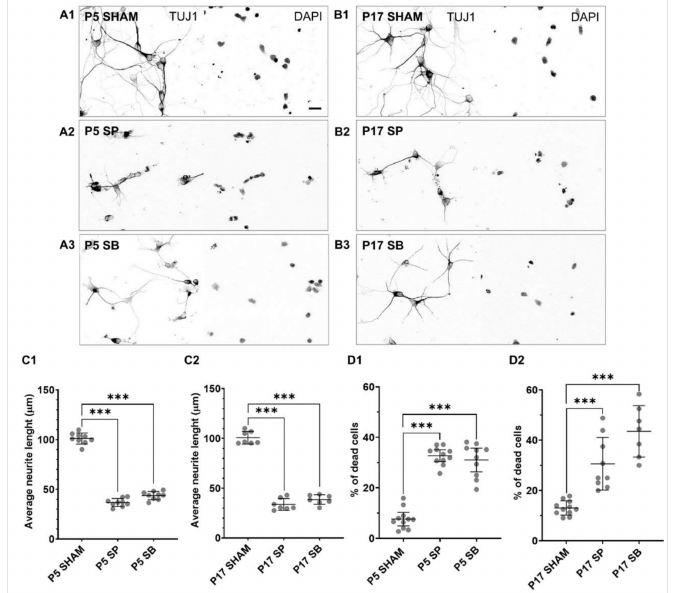
Figure 3. Reticence of neuronal differentiation by ATF3 inhibition. Primary neuronal cultures derived from the P5 ( A1 – A3 ) and P17 ( B1 – B3 ) cortex of M. domestica were treated at DIV1 with the MAPK inhibitors, JNK/c-Jun inhibitor SP600125 (SP), or the p38 inhibitor SB203580 (SB) for 24 h. The cells were fixed and stained at DIV7. Neurons were stained for TUJ1 (left panel), and their nuclei were counterstained with DAPI (right panel). For better visualization of neurites, images are shown in the grayscale. Scale bar is 20 µ m. ( C1 ) The scatter plot shows the average neurite length for P5 cortical neurons for the experimental conditions shown from ( A1 – A3 ). Data are shown as a scatter plot with mean ± SD. The total number of neurites analyzed P5 SHAM 369; SP 272; SB 346. One-way ANOVA followed by Holm-Š í d á k multiple comparisons test. P5 SHAM vs. P5 SP p < 0.001 ***; P5 SHAM vs. P5 SB p < 0.001 ***. ( C2 ) The scatter plot shows the average neurite length for P17 cortical neurons for the experimental conditions shown from B1-B3. Data are shown as a scatter plot with mean ± SD. The total number of neurites analyzed P17 SHAM 385; SP 181; SB 394. One-way ANOVA followed by Holm-Š í d á k multiple comparisons test. P17 SHAM vs. P17 SP p < 0.001 ***; P17 SHAM vs. P17 SB p < 0.001 ***. ( D1 ) The scatter plot shows the percentage of dead cells with mean ± SD for the experimental conditions shown from ( A1 – A3 ): The total number of cells analyzed, respectively: 897, 468, 497. One-way ANOVA followed by Holm-Š í d á k multiple comparisons test. P5 SHAM vs. P5 SP p < 0.001 ***; P5 SHAM vs. P5 SB p < 0.001 ***. ( D2 ) The scatter plot shows the percentage of dead cells with mean ± SD for the experimental conditions shown from ( B1 – B3 ): The total number of cells analyzed, respectively: 437, 164, 185. One-way ANOVA followed by Holm-Š í d á k multiple comparisons test. P17 SHAM vs. P17 SP p < 0.001 ***; P17 SHAM vs. P17 SB p < 0.001 ***. For each condition, images of at least three random fields per sample from 3 culture preparations were